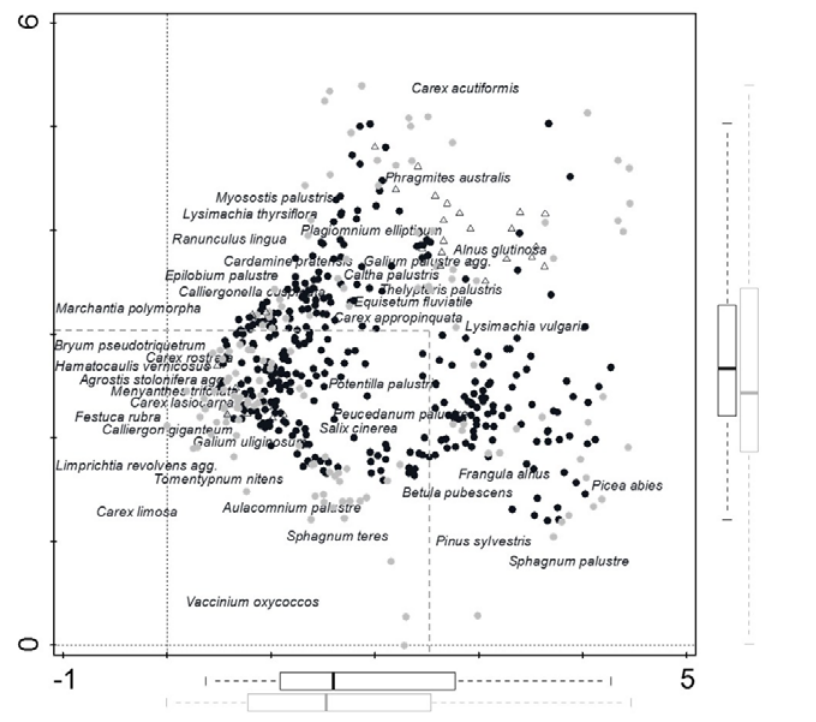
Figure 9. Detrended correspondence analysis of vegetation relevés from the Rospuda mire. Grey dots: relevés from the 1980s (from Sokołowski (1996); data for aquatic plant communities and vegetation on mineral soils discarded); black dots: relevés from 2006–2008; triangles: additional relevés from 2010–2013. All vegetation layers combined. Eigenvalues: I – 0.5503, II – 0.3699, III – 0.2317, IV – 0.1974. The most important 40 species (of the 405 recorded in total) are shown. The grey dashed lines delimit the part of this ordination that is shown (enlarged) in Figure 10. The DCA plot is supplemented with boxplots summarising the scores of samples along the first and second DCA axes (minimum, first quartile, median, third quartile and maximum values); grey boxplots represent 1980s relevés and black boxplots represent relevés recorded in 2006–2013.